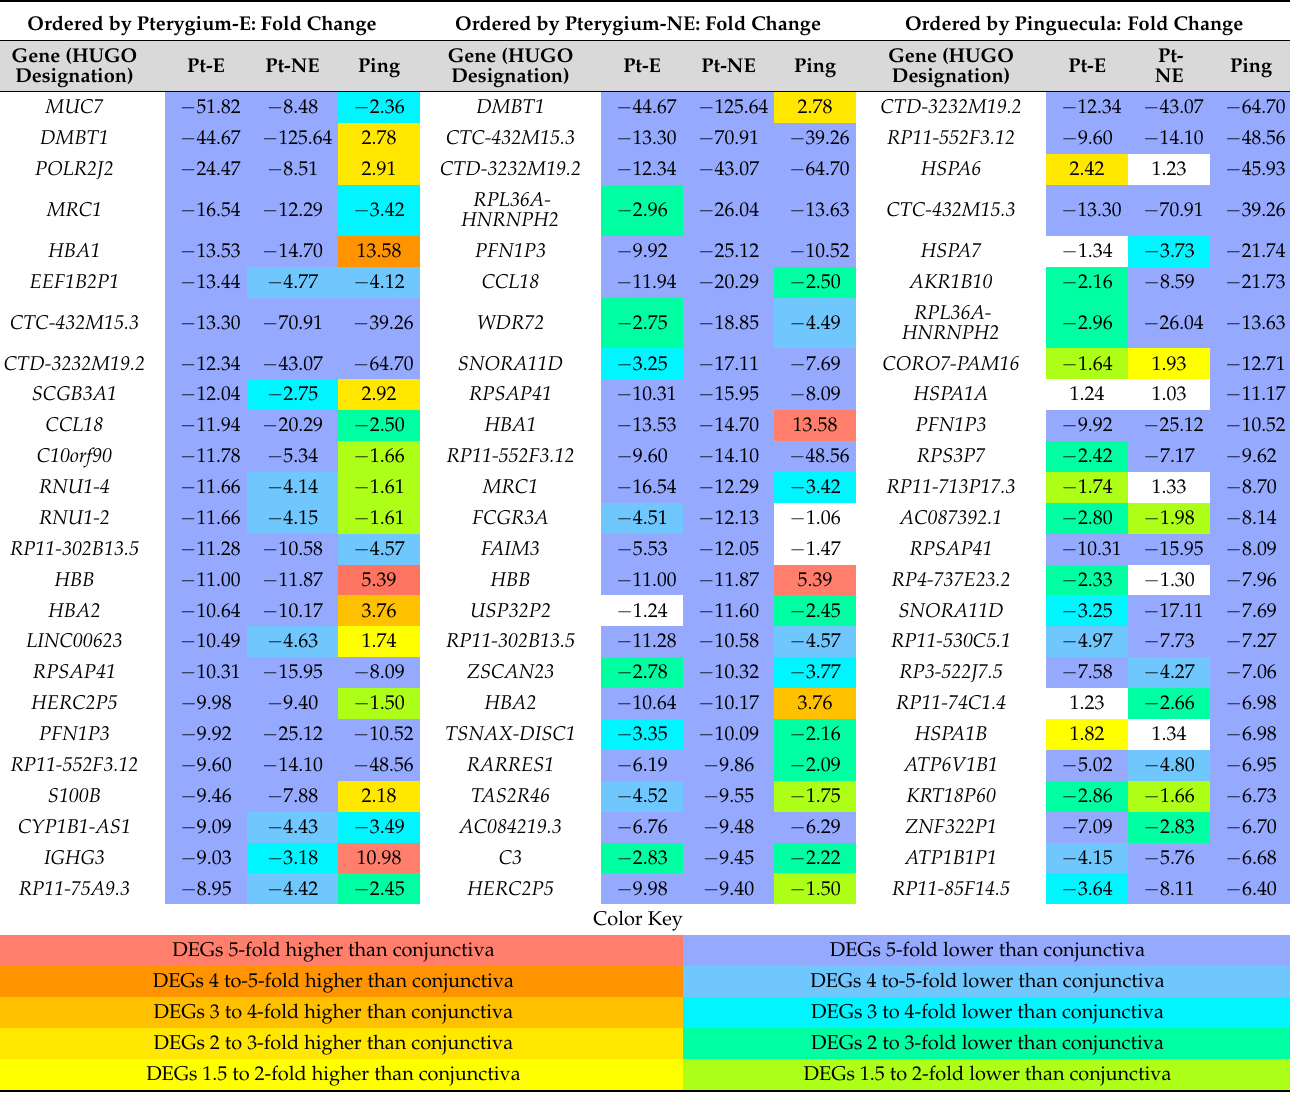
Table 3. Top 25 Genes Downregulated with Respect to Normal